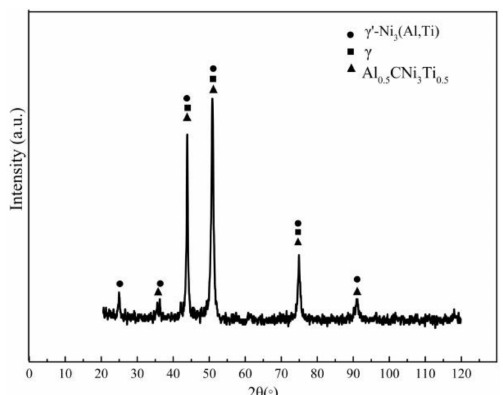
Figure 2. X-ray diffractometer (XRD) diffraction pattern of the laser forming repaired (LFRed) K417G.